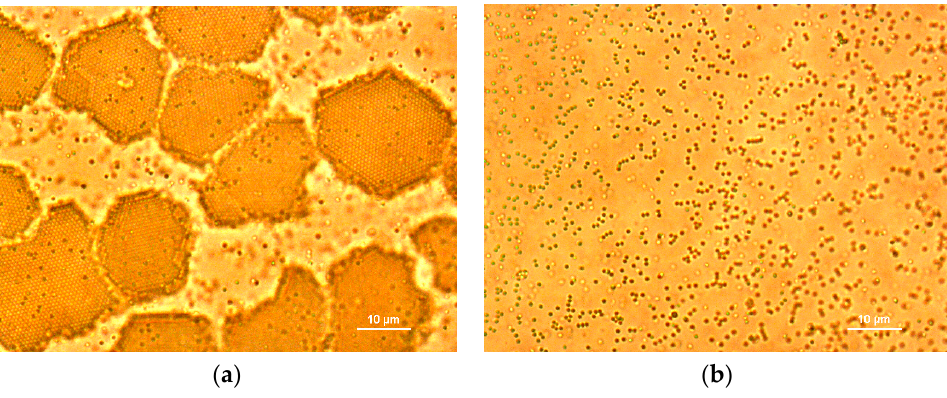
Figure 2. Re-dispersion of particles from grown crystals. ( a ) 1 day after sample preparation; ( b ) 6 days after sample preparation. In a day, crystals grow up to several layers as shown in ( a ) at 25 °C. However, 3 days after sample preparation, the crystals start to dissolve, and 6 days after, the crystals have disappeared completely.